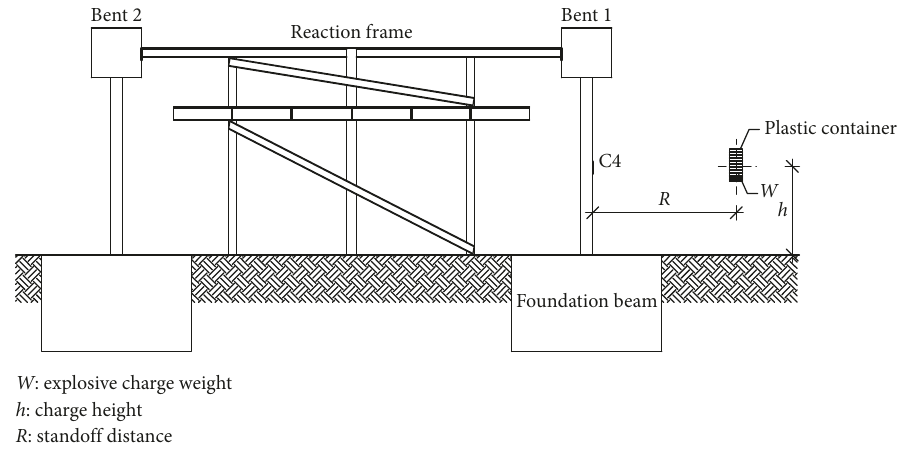
Figure 1: Test setup for column testing [5].